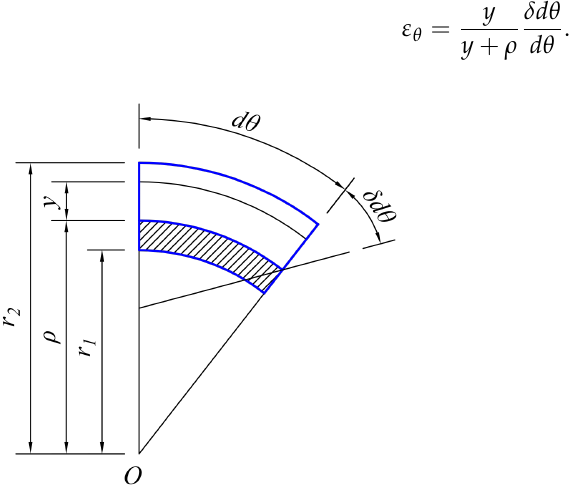
Figure 4. The geometrical relation of a segment from the curved beam.